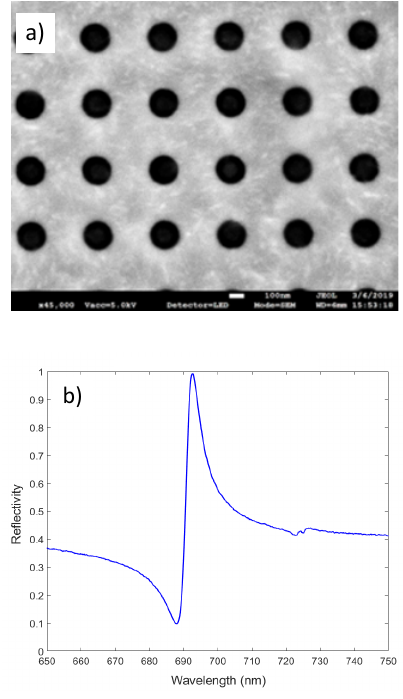
Figure 2. a) Nanohole array of 470 nm period realised in hydrogenated amorphous silicon. b) Corresponding Fano resonance. Note the large dynamic range and the near-100% reflectivity at a wavelength below 700 nm, which highlights the low loss of the hydrogenated a:Si